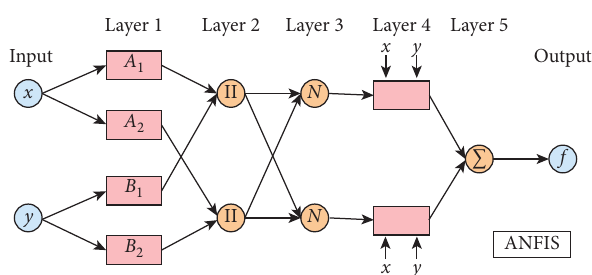
Figure 2: The structure of the adaptive neuro-fuzzy inference system